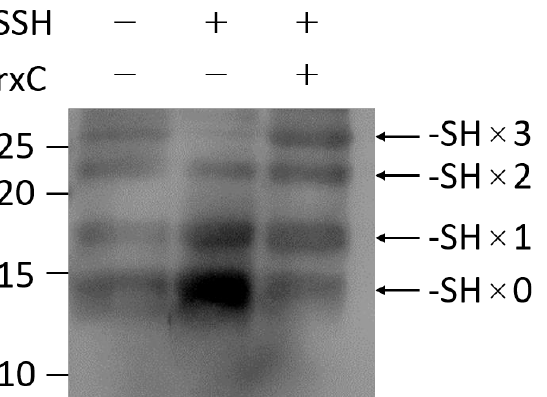
Figure 2. Shift in SqrR SDS-PAGE mobility caused by thiol modification. Reduced, GSSH-treated, and GSSH- and TrxC-treated SqrR-FLAG samples were labeled with PEG-maleimide. Each PEG- maleimide-modified SqrR was detected by Western blotting using an anti-FLAG antibody. Labels to the right of the image indicate the number of modified cysteine thiols. The numbers to the left of the image indicate molecular weight based on size markers (kDa).